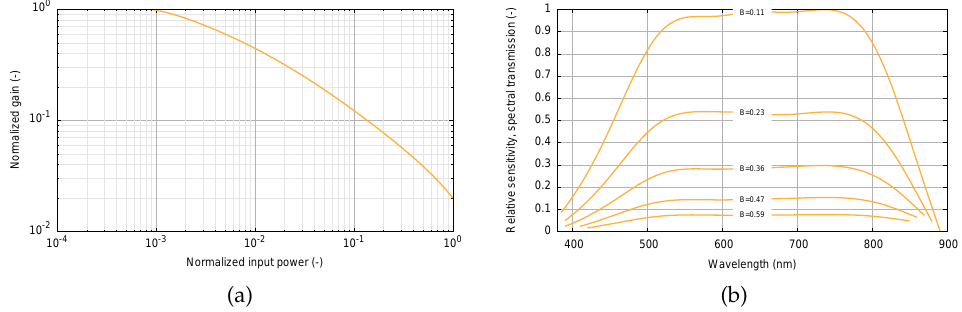
Figure 3. Properties of the MAIA system ( a ) Gain of the intensifier; ( b ) Spectral